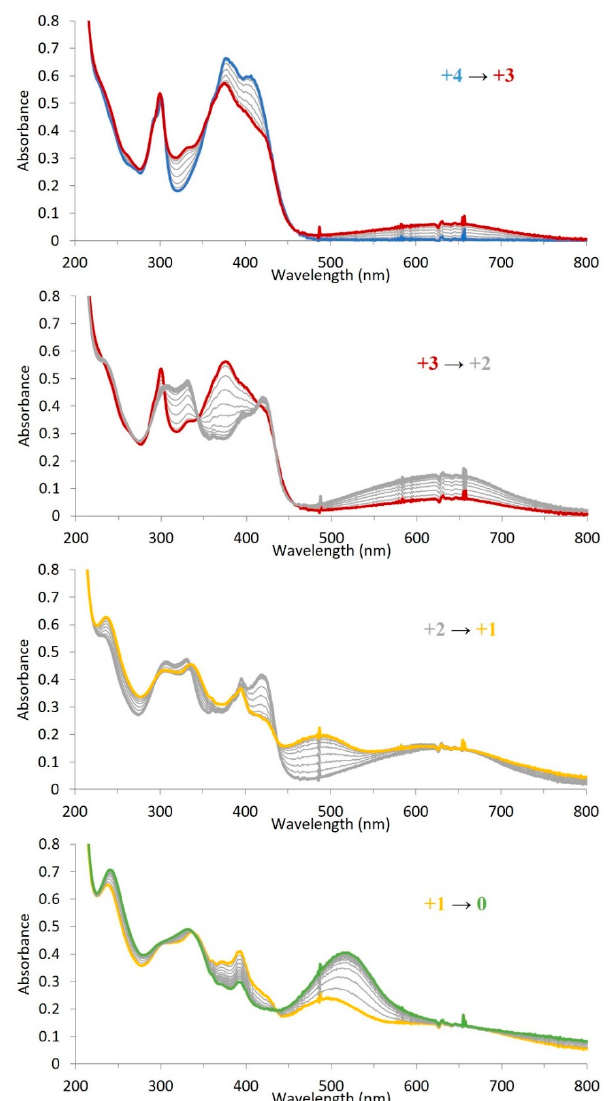
Figure 2. UV-vis spectra recorded at regular intervals from − 250 to − 525 mV ( top ), − 525 to − 875 ( second ), − 875 to − 1250 ( third ), and − 1250 to − 1700 mV ( bottom